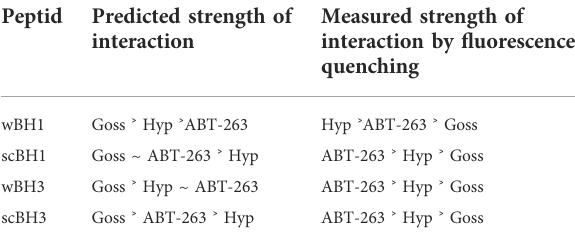
TABLE 1 Stern-Volmer constants for BH1 and BH3 peptides interactions with Hyp or Goss.